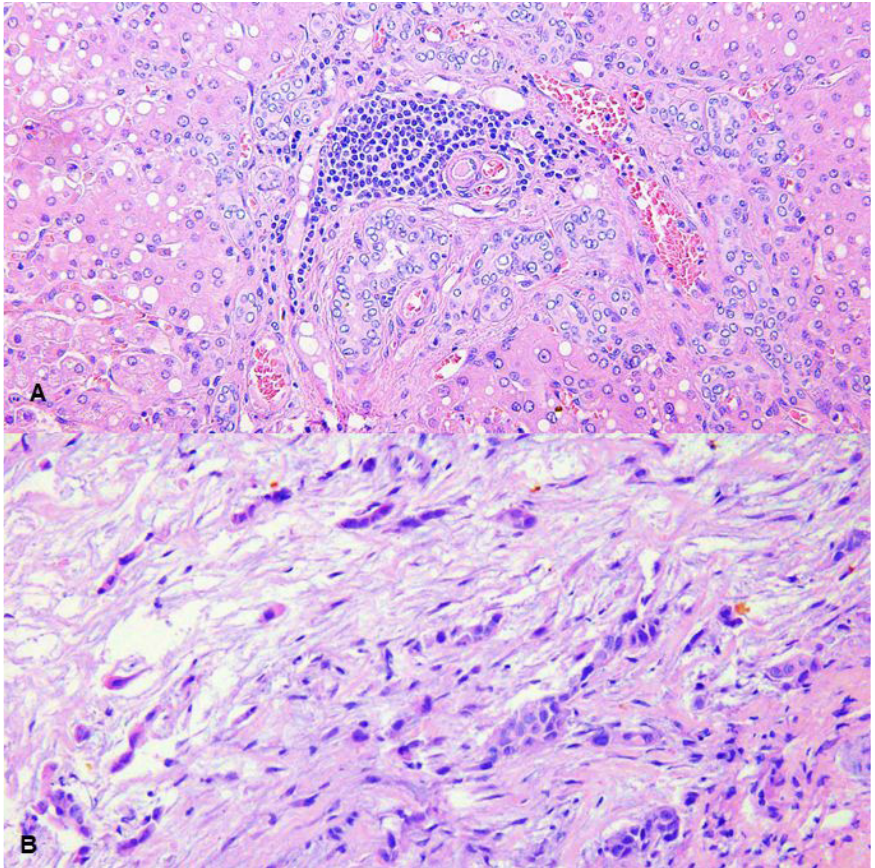
Figure 1. Photomicrographs of the liver and neoplasm tissue of extra-hepatic cholangiocarcinoma in an adult Black Howler Monkey ( Alouatta caraya ). (A) Liver tissue showing vacuolization of hepatocytes, leading to a swollen appearance, a portal region with the accentuated proliferation of biliary ducts and mononuclear inflammatory infiltrate. Hematoxylin-eosin staining (200x); (B) Bile duct mass tissue, showing proliferation of neoplastic cells with infiltrative growth pattern, arranged in cords or islands, and occasionally isolated in the abundant fibrous stroma. Hematoxylin-eosin staining